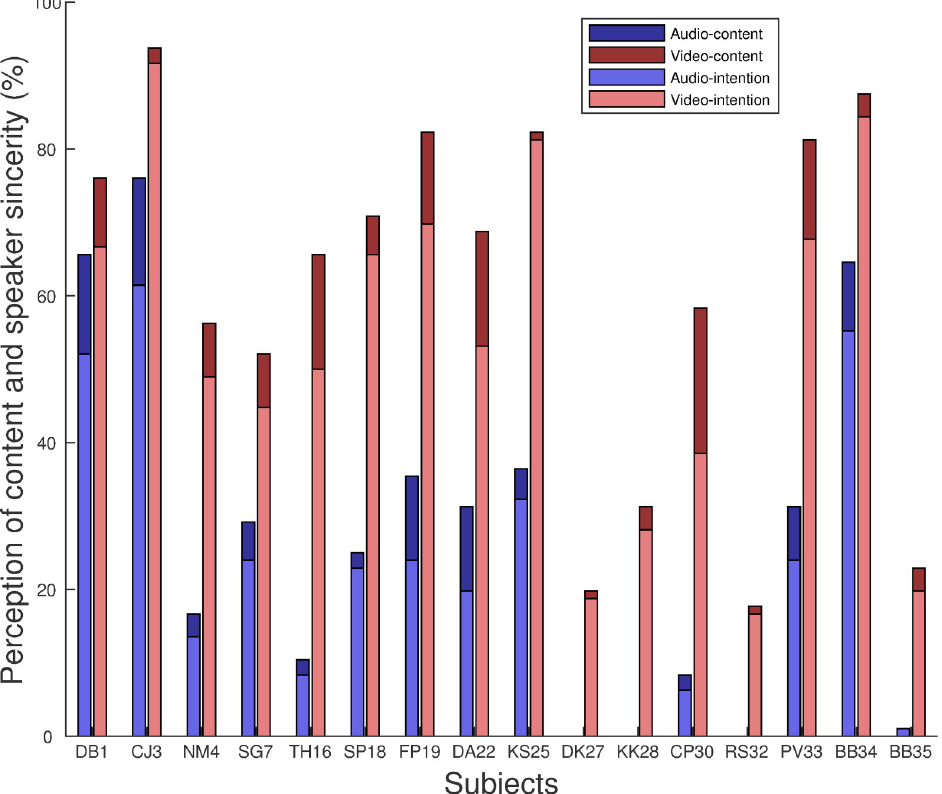
Fig 1. Performance for individual subjects. Blue bars represent performance in the audio-only condition. The red bars represent the audio-visual condition. The bars represent the percentages of correctly perceived conversations in terms of the content question (dark-colored bars) and identifying speaker sincerity (light-colored bars) relative to the total number of stimuli.